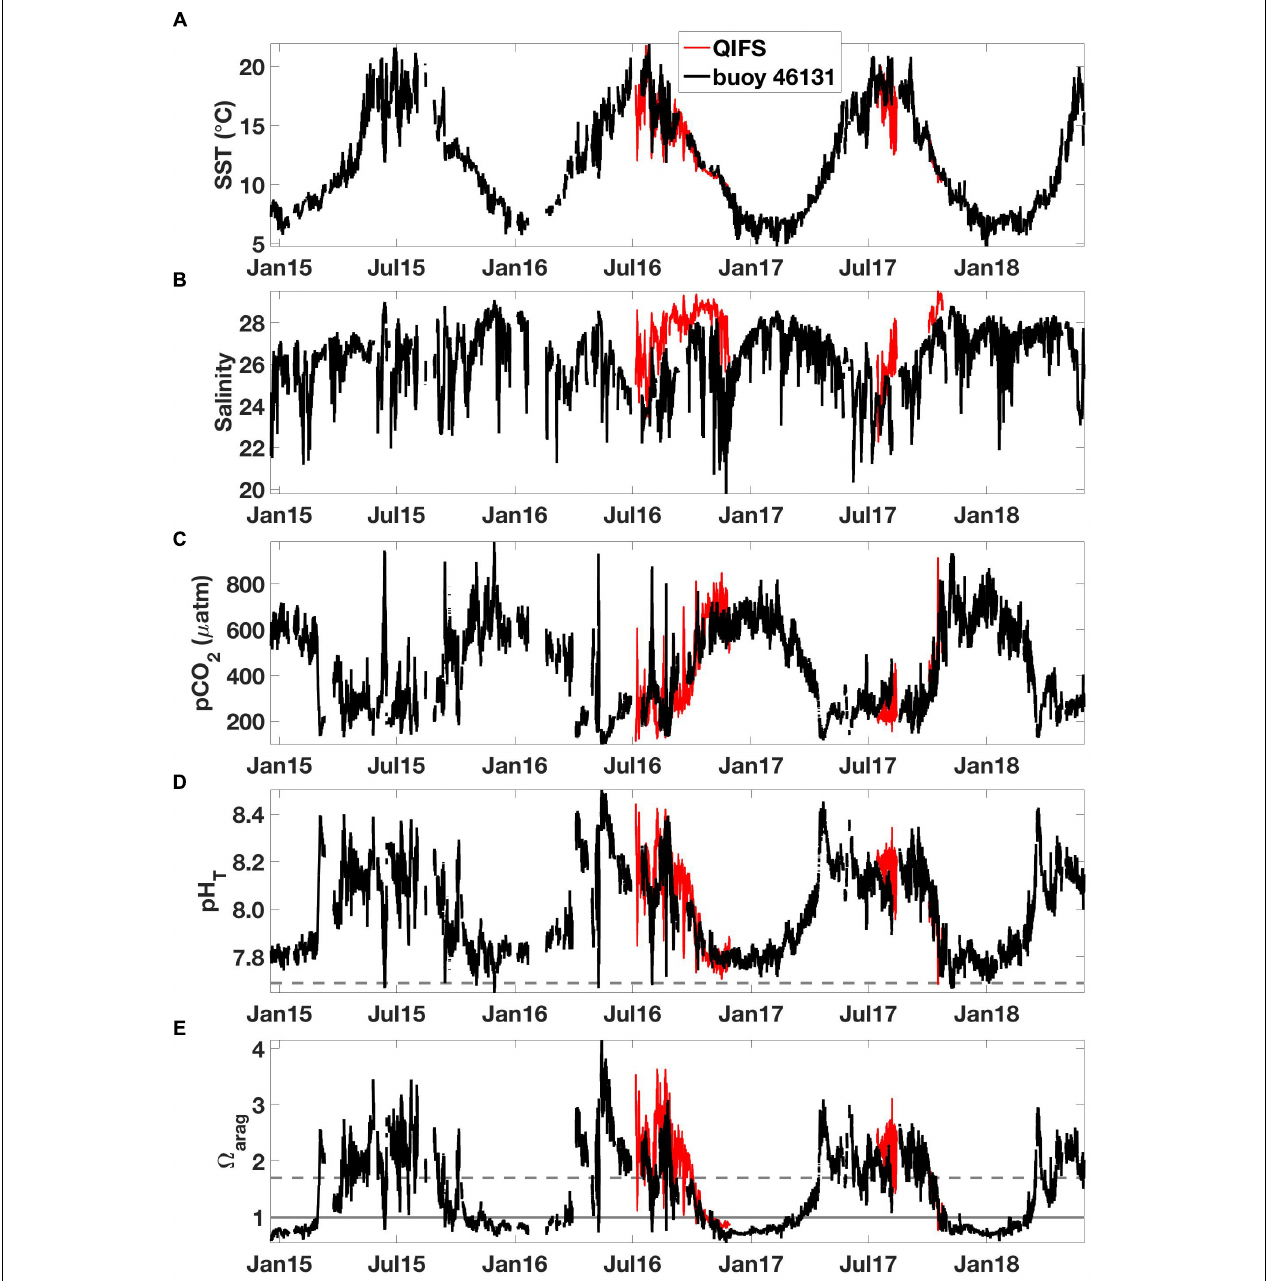
FIGURE 4 | High-resolution observations of (A) SST ( ◦ C), (B) salinity, (C) pCO 2 ( µ atm), (D) pH T , and (E) (cid:127) arag from the QIFS (black) and Environment Canada buoy 46131 (red). The horizontal line in (D) marks pH T = 7.69, and the horizontal lines in (E) mark (cid:127) arag = 1 (solid gray) and (cid:127) arag = 1.7 (dashed gray).